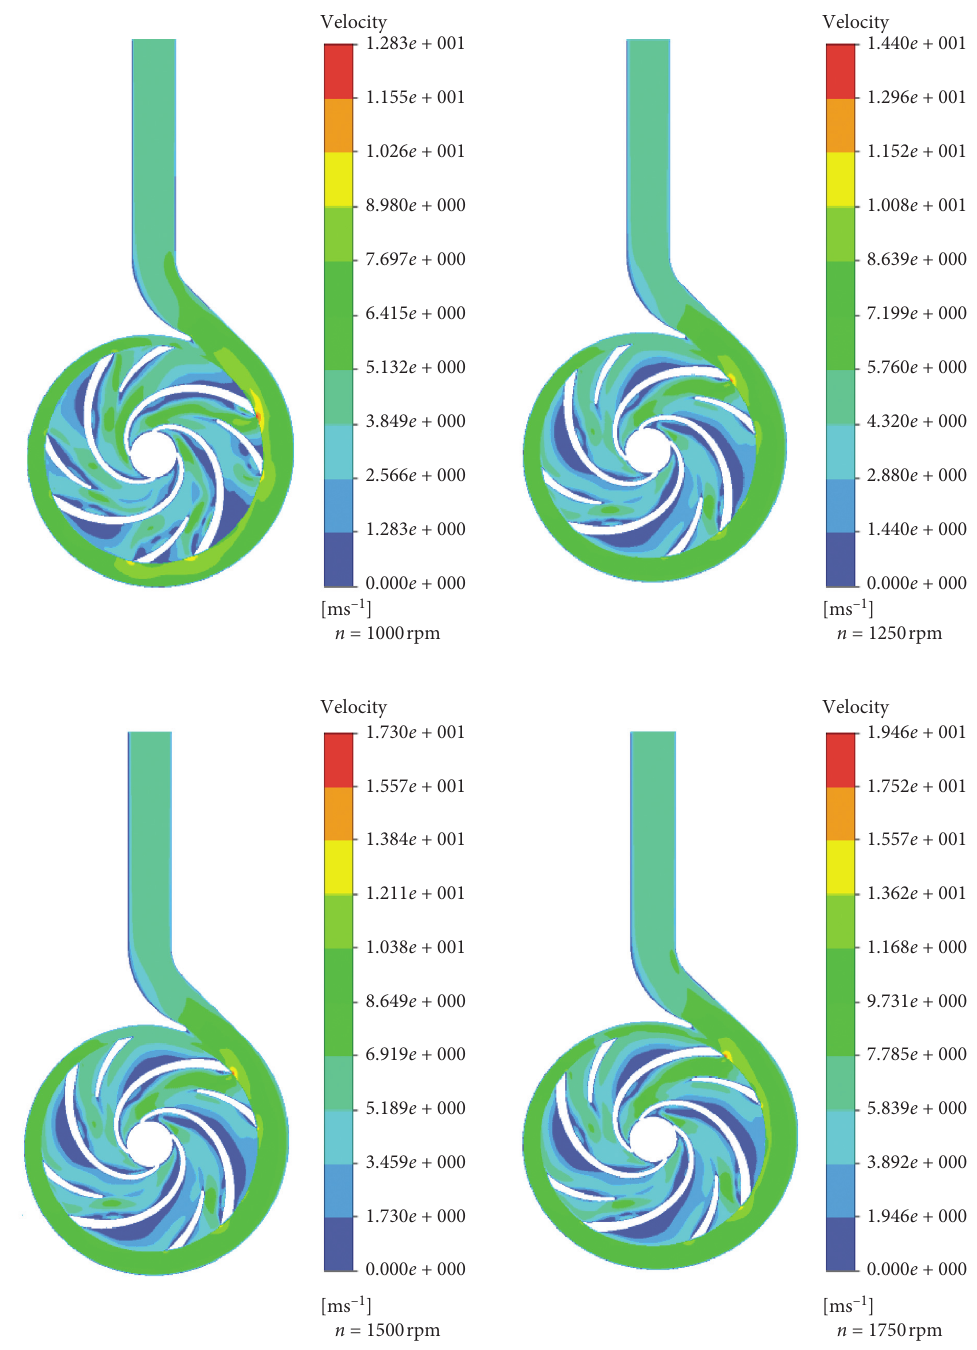
Figure 5: 3D velocity distribution of the selected centrifugal PAT model in diverse speed at